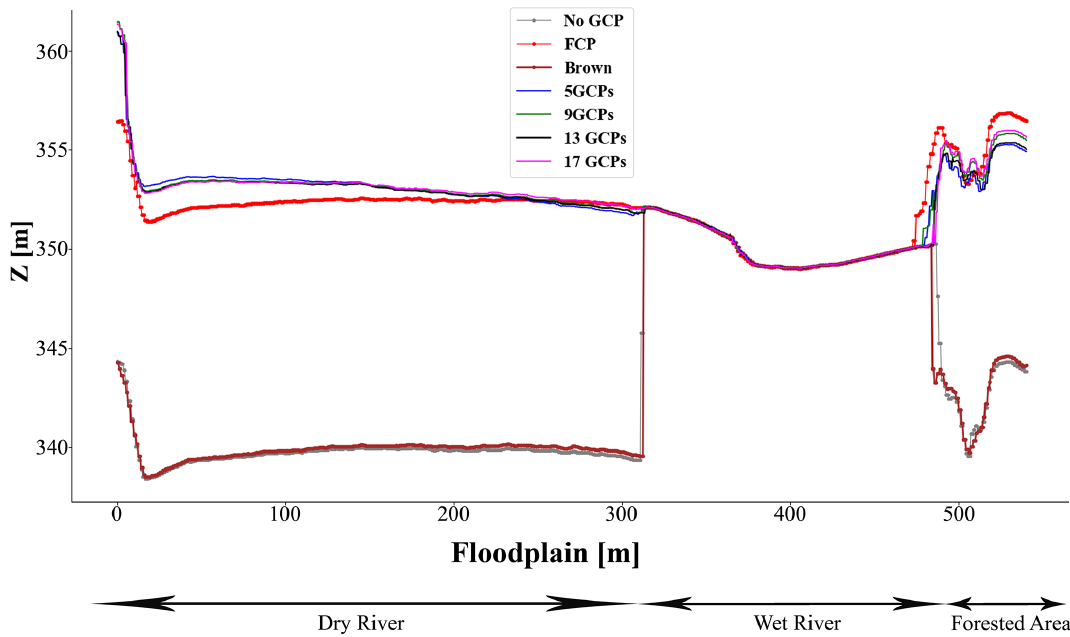
Figure 15. Extract of cross section 1 with the combined geometry of dry and wet